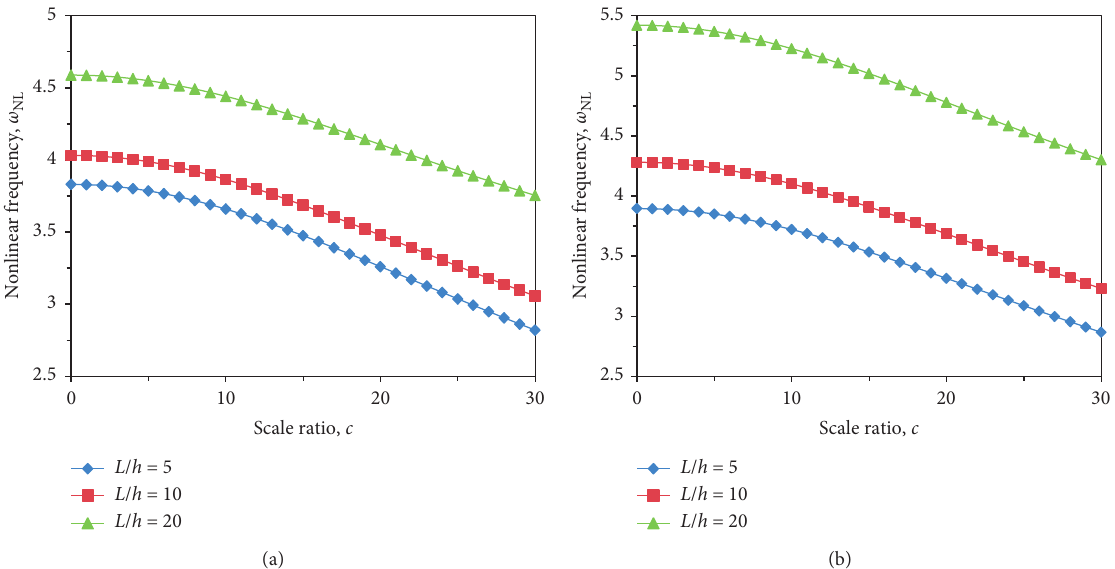
Figure 8: The variation of the nonlinear frequencies of the FG nanobeams to the scale ratio for k � 2, β � 0 . 01, and V thickness effect; (b) with thickness